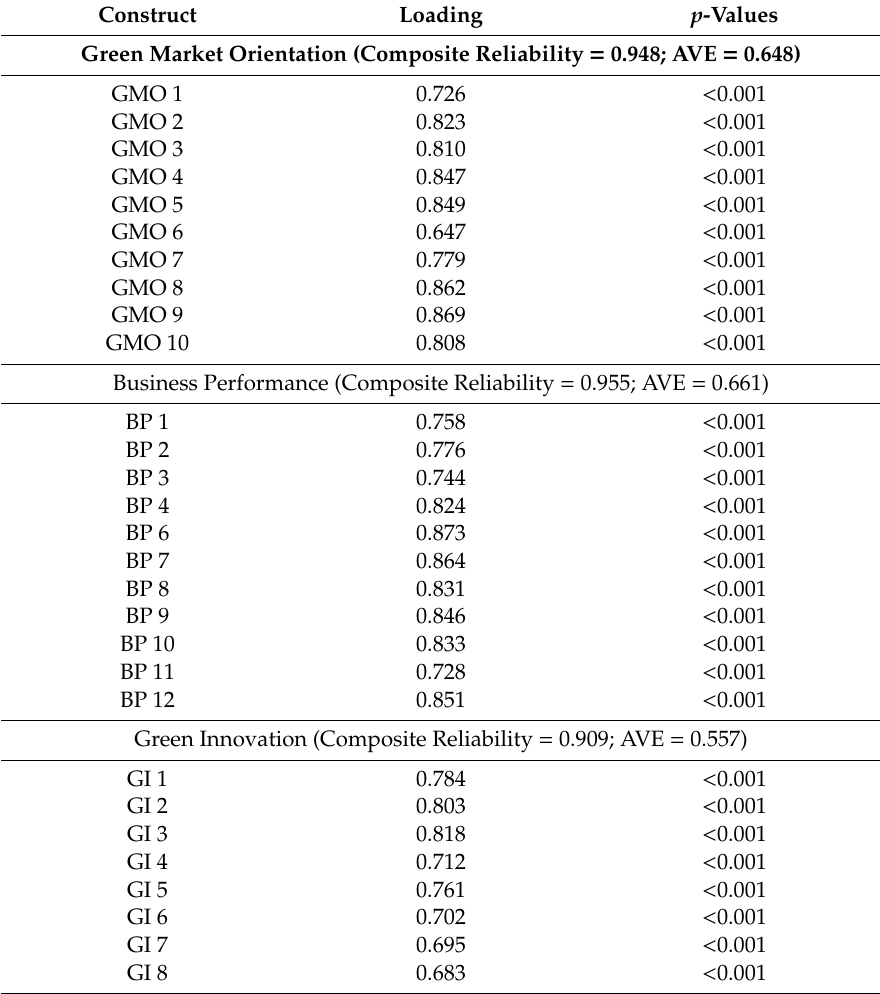
Table 3. Reliability and convergent validity.